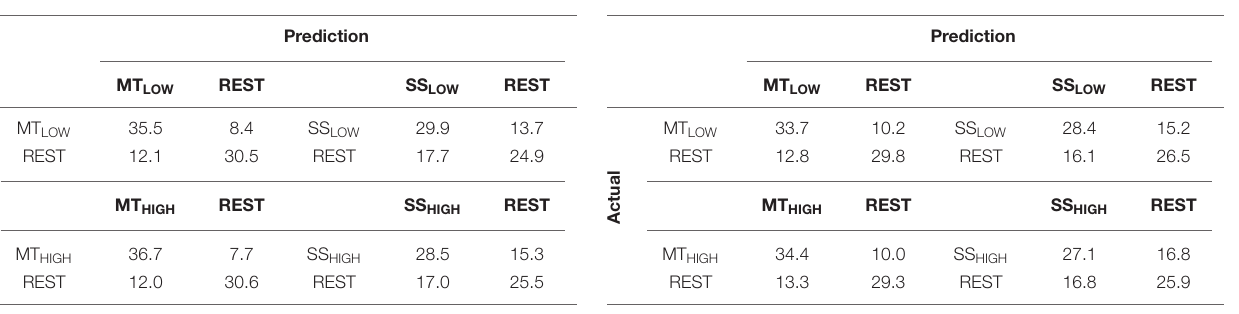
TABLE 4 | Confusion matrices summarizing the classification performance of the four regular classifiers (RC) using alpha and beta band features averaged over all subjects ( n = 13).